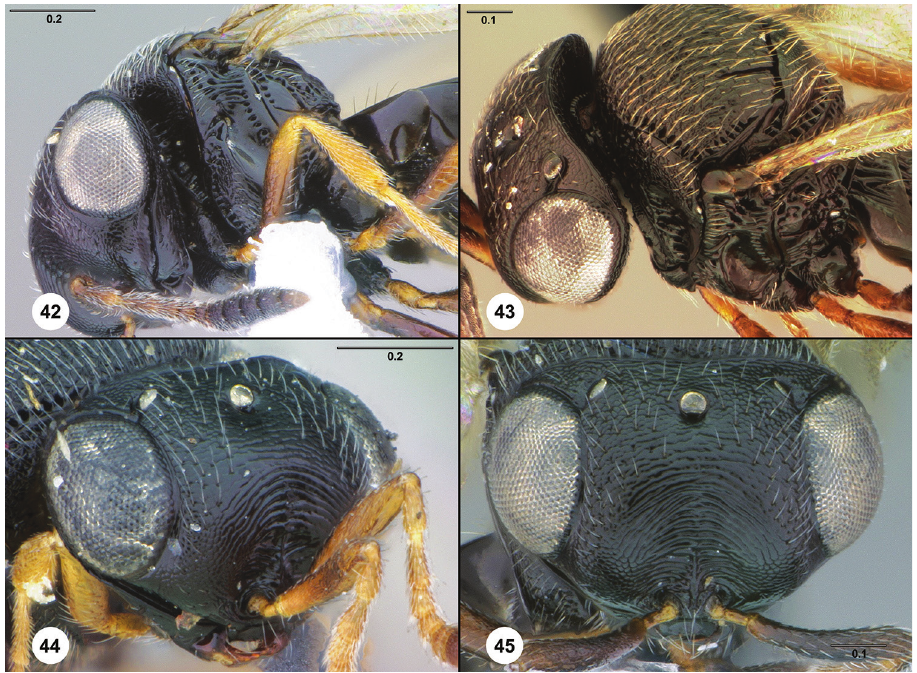
Figures 42–45. Trissolcus cultratus 42 female (USNMENT00916251), head and mesosoma, ventrolateral view 43 female (USNMENT00764849), head and mesosoma, dorsolateral view 44 female lectotype (NHMW 0008A), head, anterolateral view 45 female (USNMENT00916251), head, anterior view. Scale bars in millimeters. striate. Macrosculpture of frons between antennal scrobe and anterior ocellus: parallel arcuate rugae. Preocellar pit: present. Setation of lateral frons: sparse. Punctation of lateral frons: sparse. Sculpture directly ventral to preocellar pit: microsculptured. Mac- rosculpture of lateral frons: obliquely striate, striae of upper frons extending ventrolat- erally. OOL: separated by less than one ocellar diameter. Hyperoccipital carina: com- plete. Macrosculpture of posterior vertex: absent. Microsculpture on posterior vertex along occipital carina: present. Anterior margin of occipital carina: coarsely crenulate. Mesosoma : Epomial carina: present. Macrosculpture of lateral pronotum directly an- terior to netrion: striate, striae formed by elongation of cells of netrion sulcus. Netrion sulcus: complete. Pronotal suprahumeral sulcus in posterior half of pronotum: undiffer- entiated from sculpture of dorsal pronotum. Number of episternal foveae: 4 or more. Course of episternal foveae ventrally: abutting postacetabular sulcus. Course of episternal foveae dorsally: extending to mesopleural pit. Subacropleural sulcus: present. Speculum: transversely strigose. Mesopleural pit: extending ventrally into dorsoventral furrow paral- lel to mesopleural carina. Mesopleural carina: complete; well defined anteriorly, poorly defined to absent posteriorly. Sculpture of femoral depression: smooth. Patch of striae at posteroventral end of femoral depression: absent. Setal patch at posteroventral end